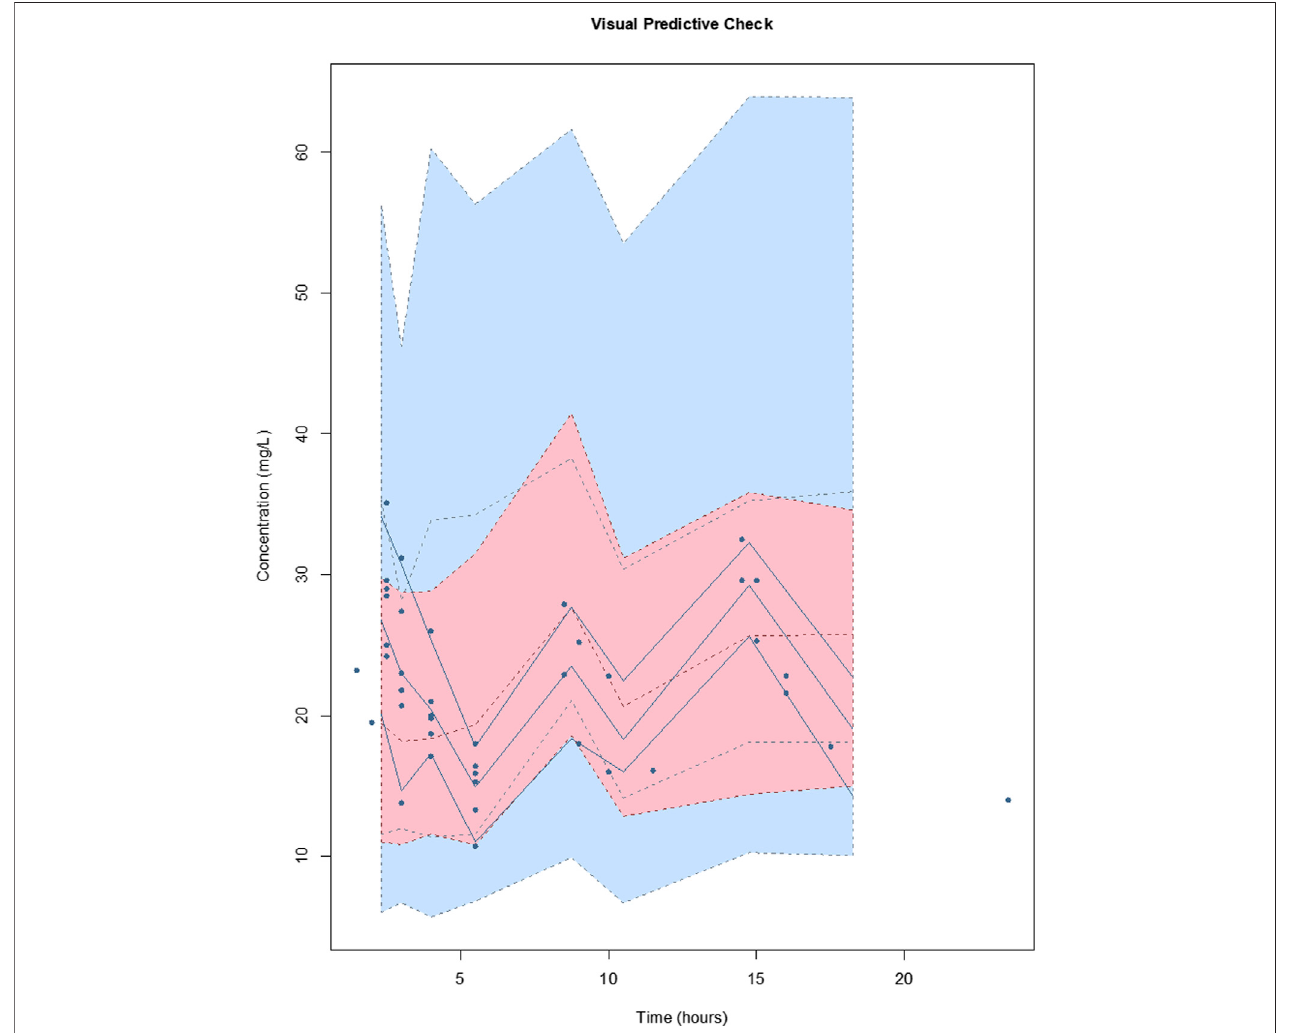
FIGURE4| Visualpredictivechecks ofthe fi nalcovariate modelforvancomycin.Thelinesrepresentthepercentilesof1,000simulatedvancomycin concentration- time pro fi les superimposed with observed vancomycin concentrations (circles). The blue shading around the lines represents the 95% CI around each percentile. The distribution of the simulated concentration pro fi les is similar to that of the observed concentrations, with all of observed concentrations between 5th and 95th simulated percentiles, respectively, suggesting that the model describes the data adequately.